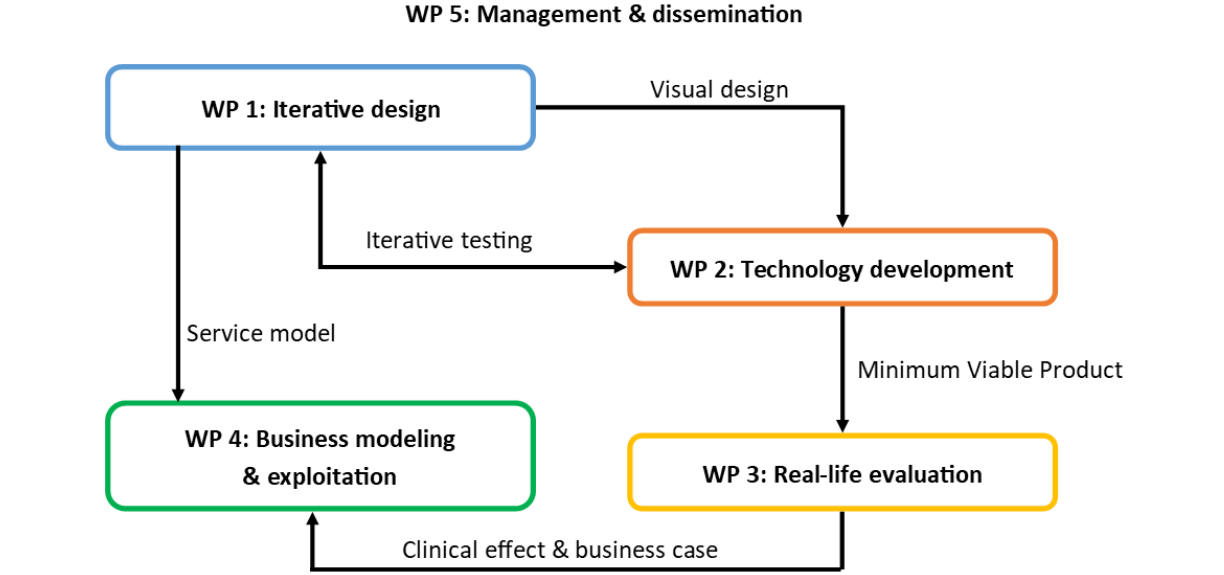
Figure 6. LEAVES (optimizing the mentaL health and resiliencE of older Adults that haVe lost thEir spouSe via blended, online therapy) work package (WP)